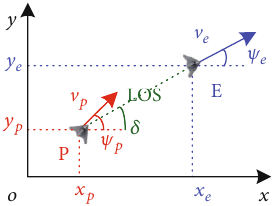
Figure 1: Geometric model of two-dimensional plane pursuit- evasion